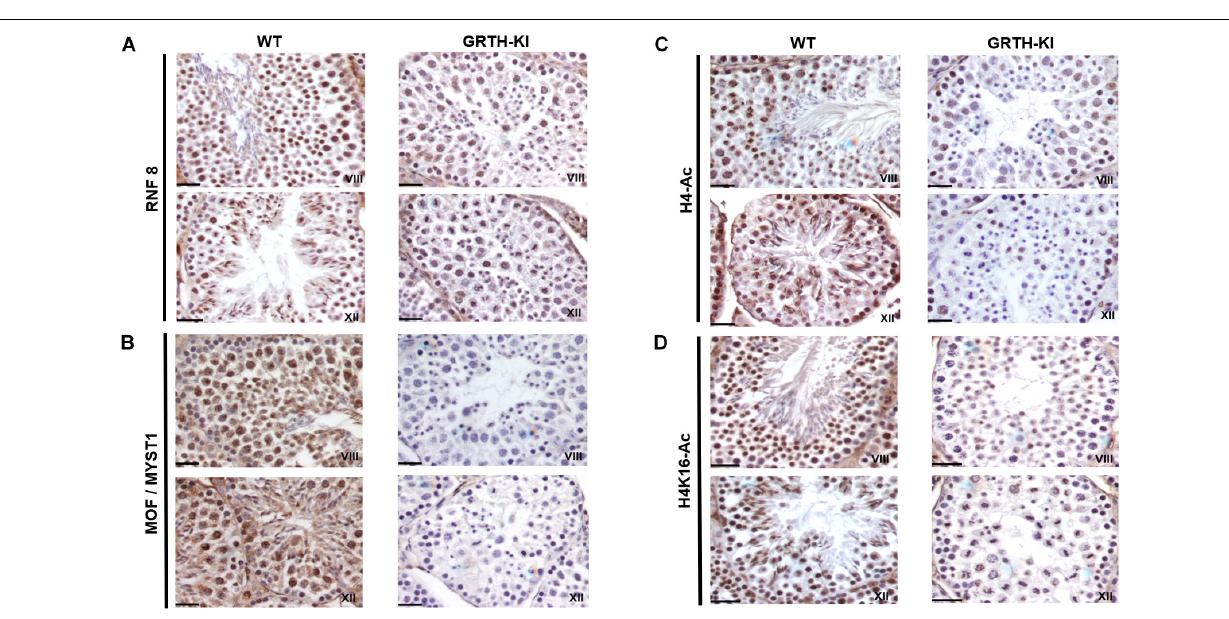
FIGURE 7 | IHC analysis of RNF8, MOF/MYST1, H4-Ac and H4K16-Ac in seminiferous tubules of WT and KI mice. RNF8 (A) , MOF/MYST1 (B) , H4-Ac (C) , and H4K16-Ac (D) expression are noticed more significantly in the nucleus of RS (stage VIII) and ES (stage XII) in seminiferous tubules of WT mice while their expression are not observed in the RS of KI